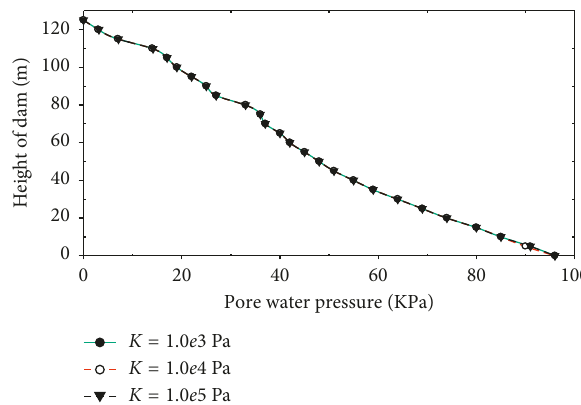
Figure 11: Comparing the pore water pressure values for different bulk modulus of water in the water-flow stage.